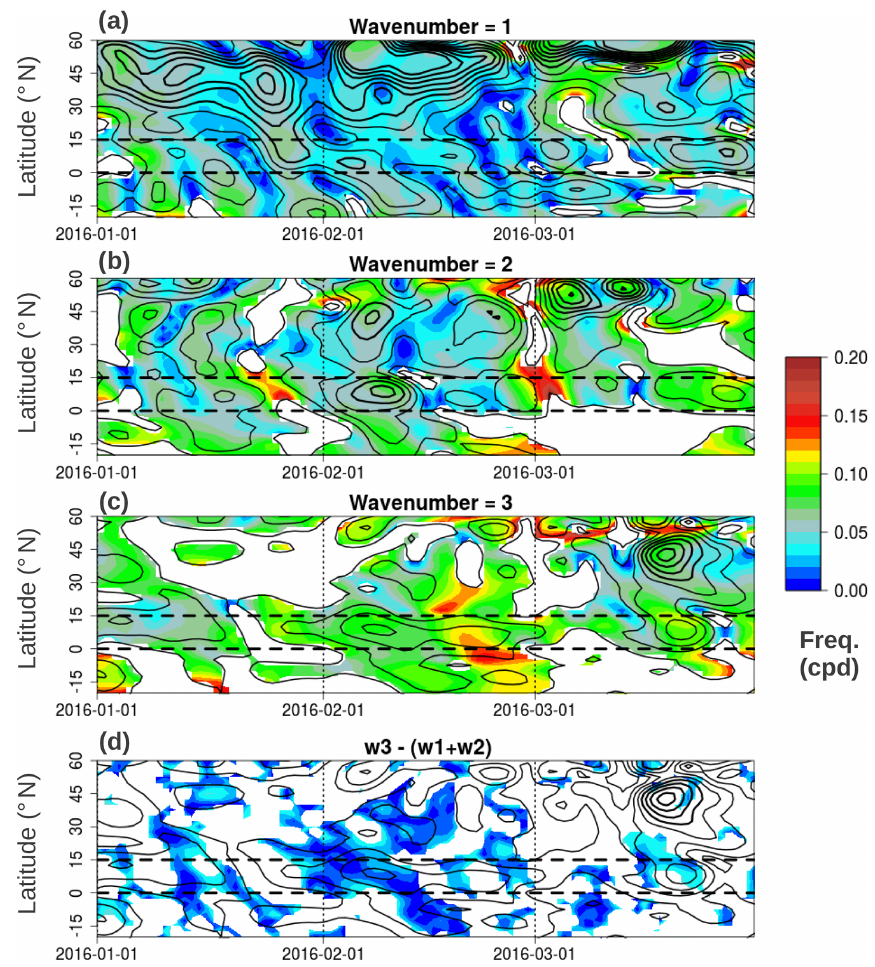
Figure 11. Time–latitude cross sections of 30hPa Rossby w0540 wave frequencies as color shadings for January–March 2016: (a) W1, (b) W2, and (c) W3. In panel (d) the absolute difference in frequency of W3 − (W1 + W2) is shown, indicating the deviation from resonant conditions. Black contours indicate amplitudes of the corresponding wavenumbers in panels (a) – (c) , starting at 1ms − 1 with that same interval. In panel (d) the black contours repeat W3 amplitudes. In panels (a) , (b) , and (c) , frequencies of waves with very low amplitude (below 1ms − 1 ) are masked out. In panel (d) , frequency differences above 0.04cpd (i.e., far from resonant condition) are masked out for better visibility. Wave properties were obtained using zonal